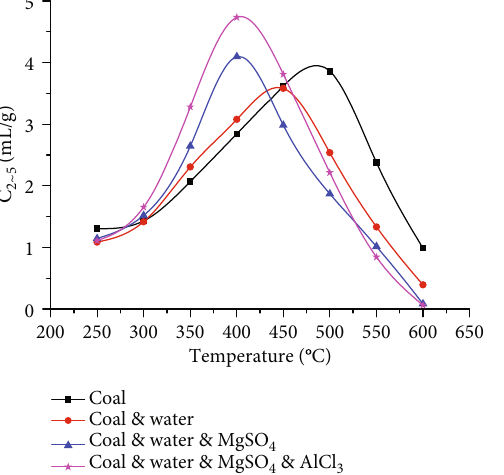
Figure 8: Variation characteristics of H